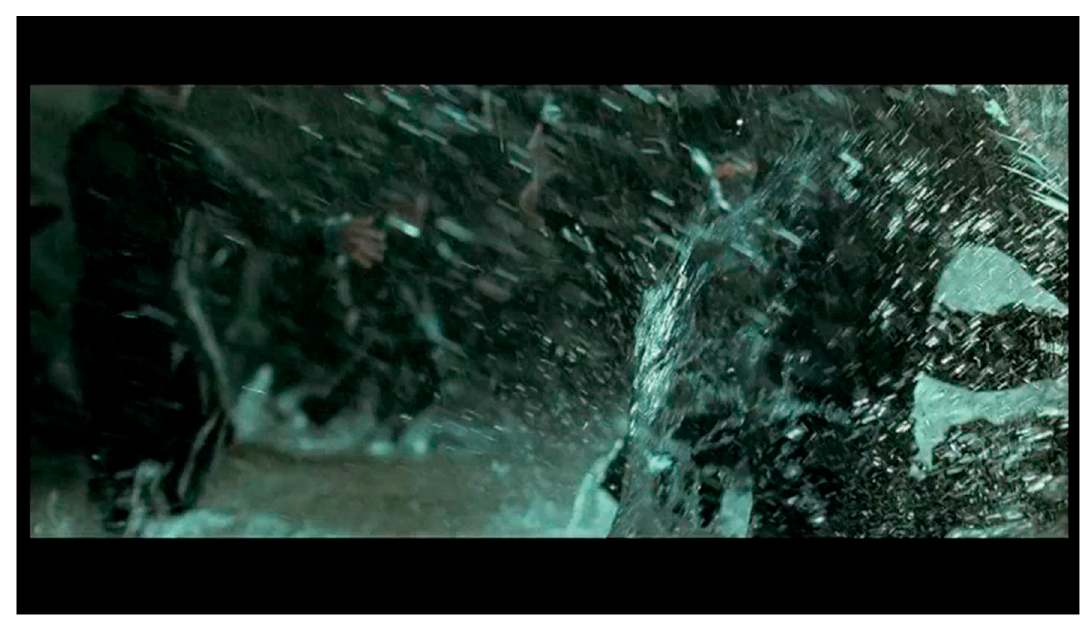
Figure 11. Raindrops interact with the actions. Frame capture, The Grandmaster (Wong 2013).